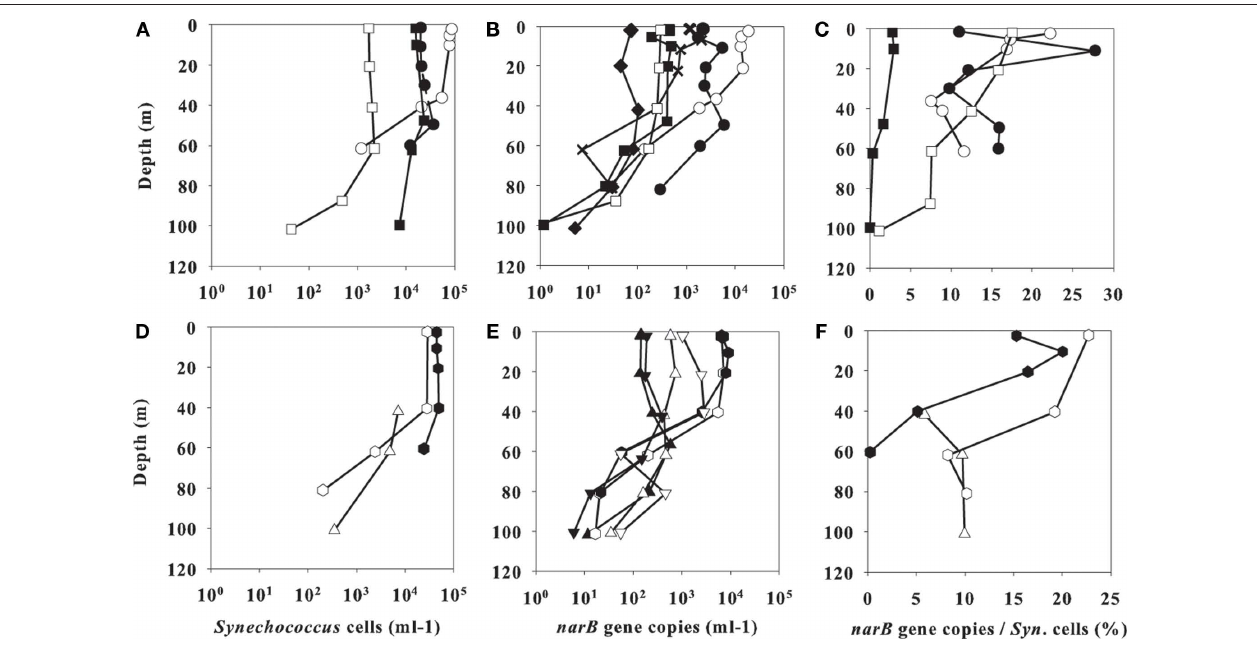
FiguRe 6 | Profile data from line 67 stations (A–C) or cyclonic eddy stations (D–F). FCM-based Synechococcus cell counts are in (A,D) , total abundances of examined narB subgroups are in (B,e) , and percent total narB subgroup